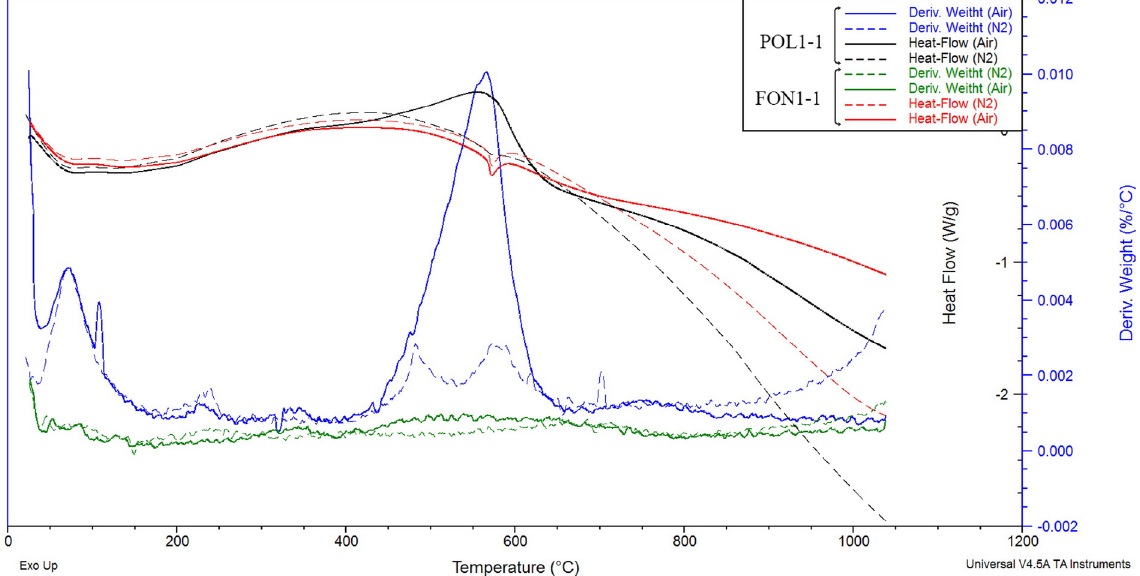
Figure 8: Thermogram of two samples, one type 1 (FON1-1) and another type 2 (POL1-1). In cherts of type 2 there is a loss of mass between 450ºC-650ºC that not appears in type 1 cherts. Around 575ºC it is possible to see quartz- α to quartz - β transformation. Loss of mass. POL1-1 2.09% and FON1-1